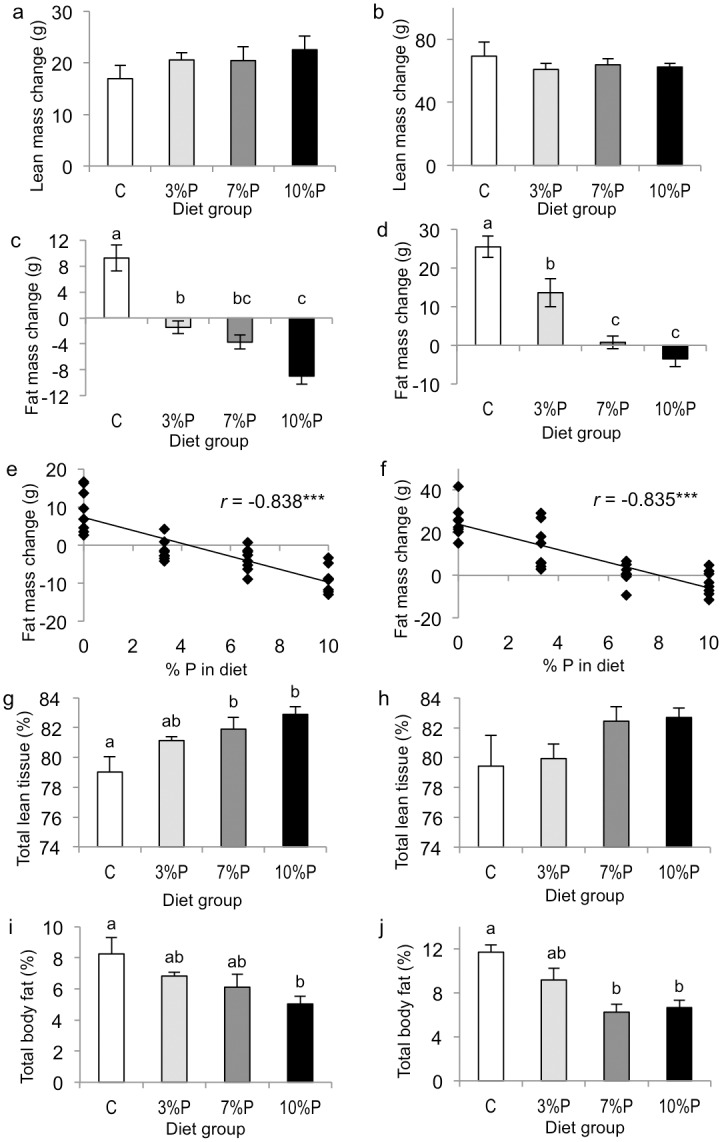
Body composition (by MRI).Changes in total lean tissue mass (a, b) and total fat mass (c, d), correlation between change in body fat mass and amount of pectin in the diet (e, f), final total body lean tissue percentage (g, h), and final total body fat percentage (i, j) in rats offered control diet (C) or diet containing 3, 7 or 10% pectin (P) for 8 days (a, c, e, g, i) or 28 days (b, d, f, h, j). Within figures, columns labelled with different letters are significantly different by one-way ANOVA, P<0.05, and r is the Pearson product-moment correlation coefficient, ***P<0.001.